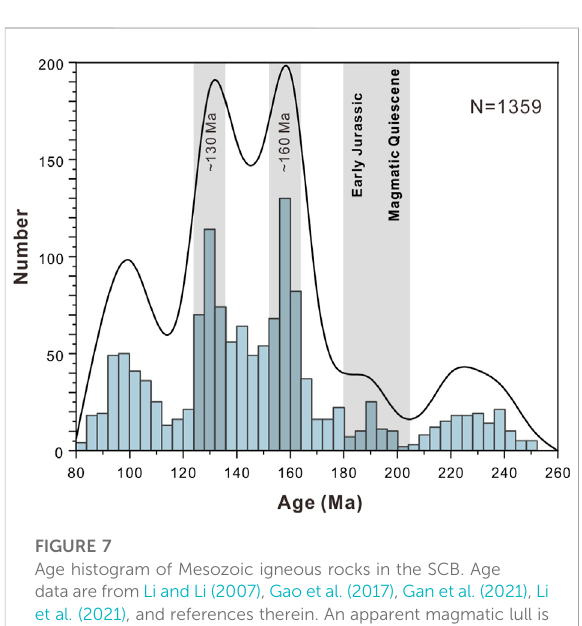
FIGURE 7 Age histogram of Mesozoic igneous rocks in the SCB. Age data are from Li and Li (2007), Gao et al. (2017), Gan et al. (2021), Li et al. (2021), and references therein. An apparent magmatic lull is inferred between the Late Triassic and the Early